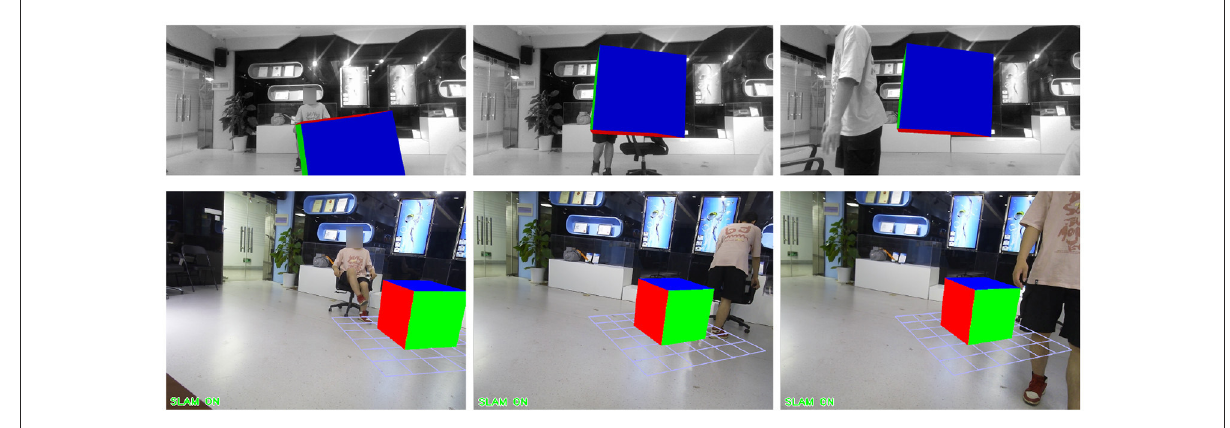
FIGURE17 Application of VINS and our method in augmented reality